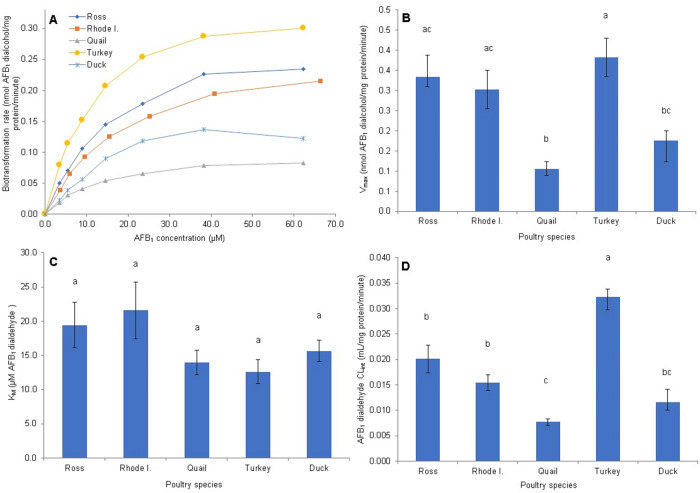
Enzyme kinetic parameters of cytosolic in vitro AFB1 dialcohol production from AFB1 dialdehyde.(A) Saturation curve at AFB1 dialdehyde concentrations of 3.4 to 66.4 μM (B) Maximal velocity (Vmax). (C) Michaelis-Menten constant (Km). (D) Intrinsic Clearance (CLint; Vmax/Km). Species mean values sharing the same letter do not differ significantly. Statistical differences (P <0.05) were calculated using the Kruskal-Wallis test and nonparametric multiple comparisons were done by the Dwass-Steel-Critchlow-Fligner method. No differences were found for Km enzyme activity parameter between poultry species. Values are means ± SEM of 12 birds.